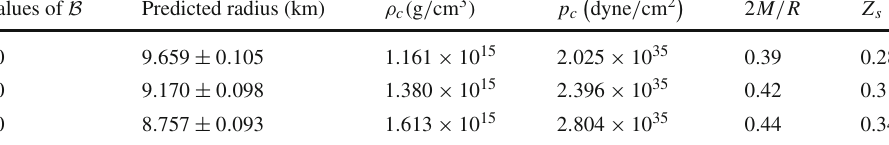
Table 2 Numerical values of physical parameters for LMC X − 4 for the different values of Λ and B = 60MeV / fm 3